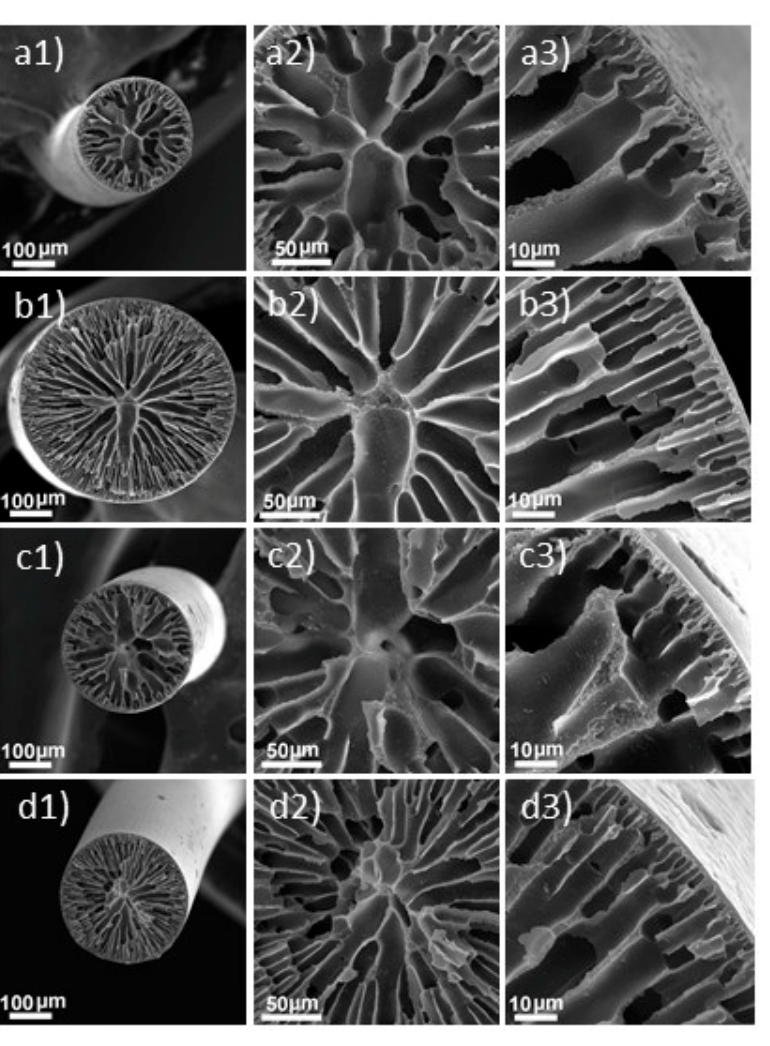
Figure 2. SEM images of fiber cross-section; ( a1 – a3 ) pristine PAN fibers, ( b1 – b3 ) PAN/H 2 O fibers, ( c1 – c3 ) PAN/GO composite fibers, and ( d1 – d3 ) PAN/GO/H 2 O composite fibers.